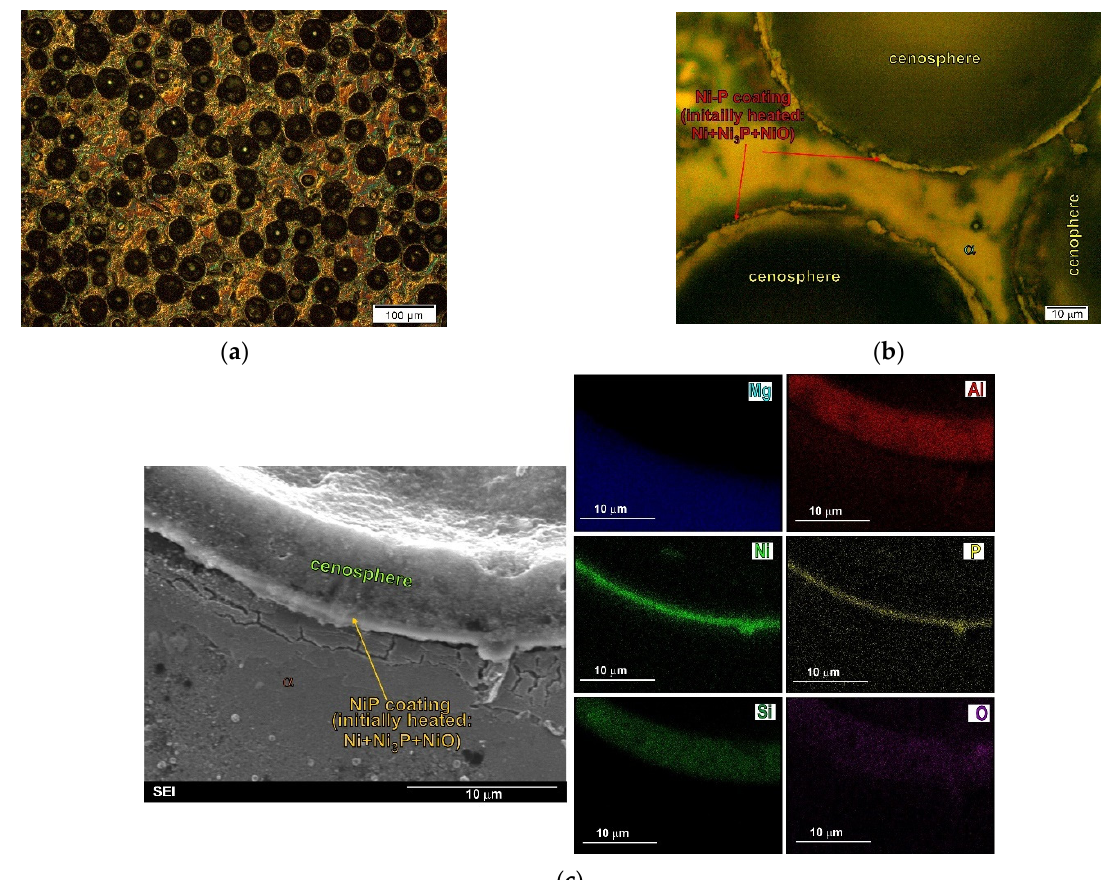
Figure 8. Microstructure of AZ91 magnesium matrix composites with Ni–P-coated (and initially heated) aluminosilicate cenospheres. ( a , b ) Micrographs taken at different magnification); ( c ) SEM micrograph of composite microstructure with EDX results.